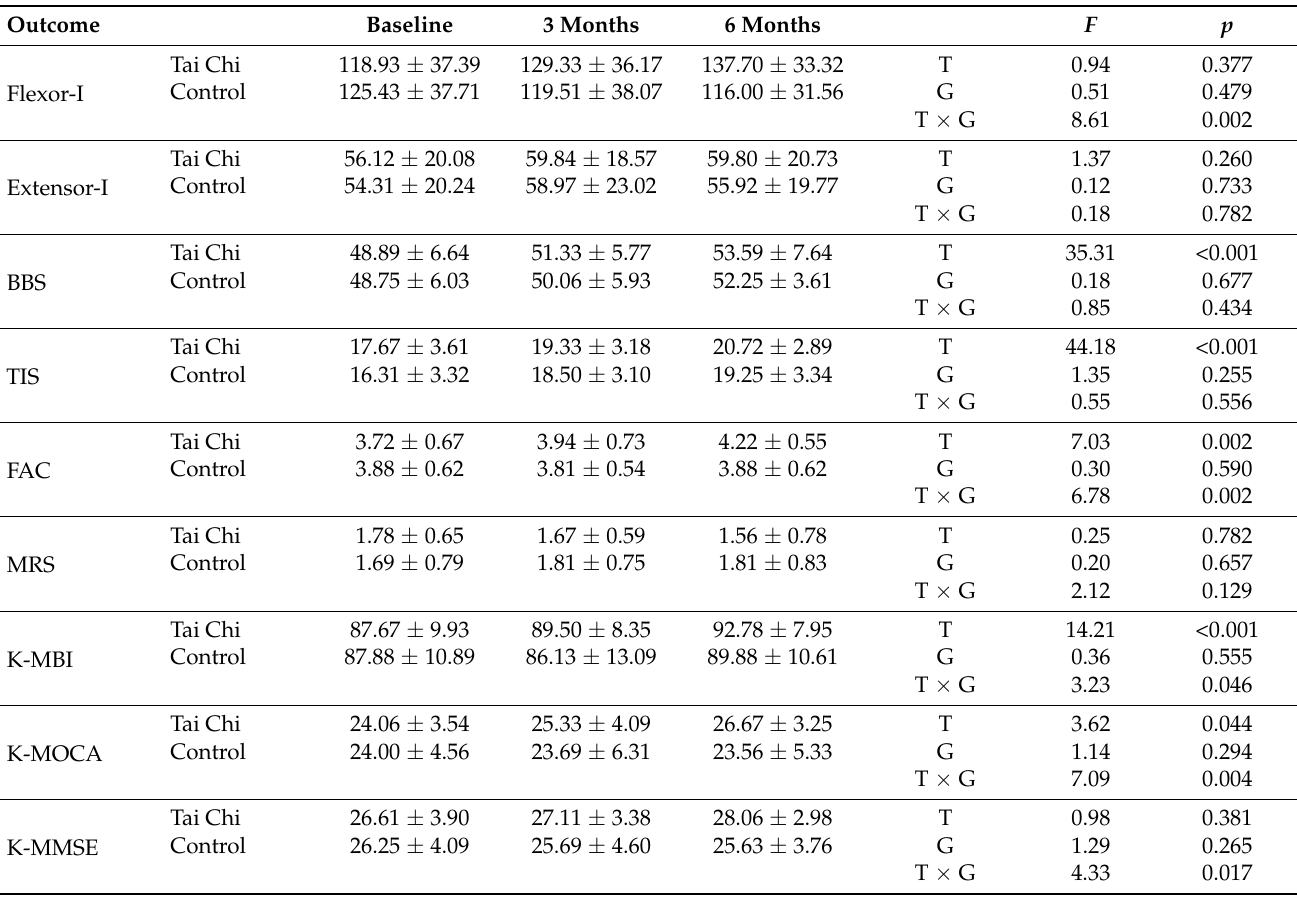
Table 4. Effects of the Tai Chi-based stroke rehabilitation program on muscle strength, physical function, and cognitive function ( N = 34).